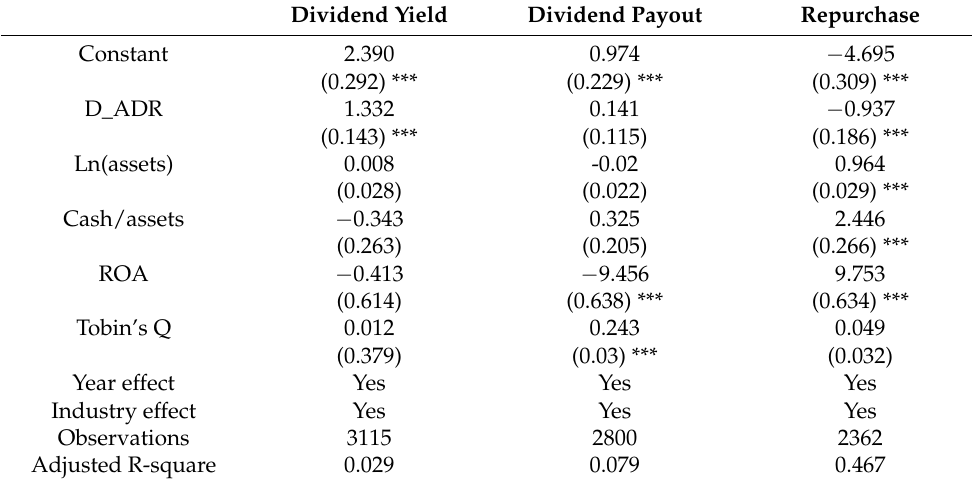
Table 4. Regression analysis with full sample. Dividend Yield Dividend Payout